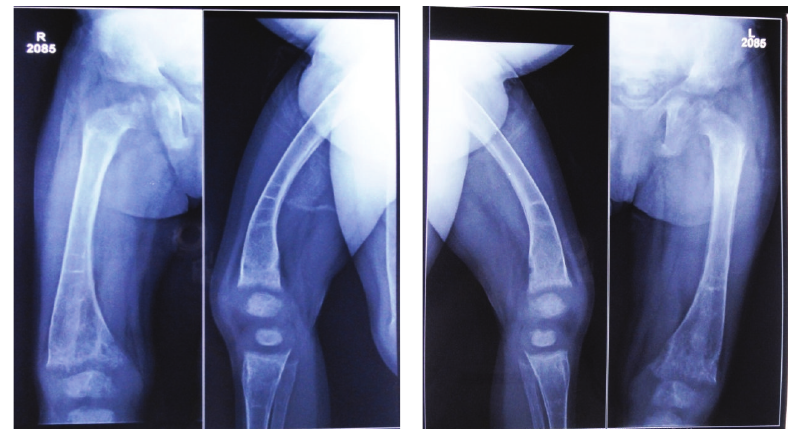
Figure 16: Radiograph of hip with femur and tibia.